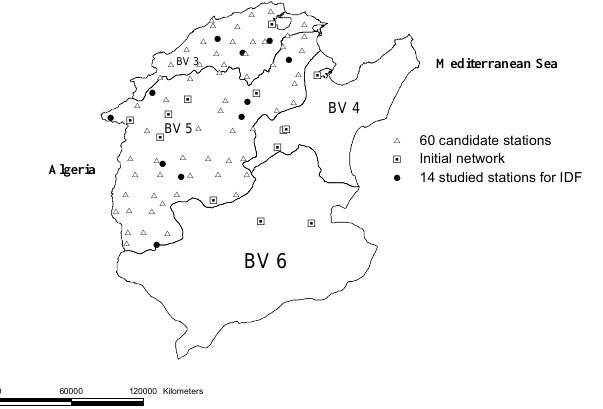
Fig. 1. Location of rain gauges in the study area (Medjerda basin Figure 1. Location of rain gauges in the study area (Medjerda basin BV5 ; Northern BV 5; northern coast basin BV 3; and surrounding basins (Meliane coast basins BV3 and surrounding basins Meliane Basin BV4 ; Central Tunisia basins basin BV 4 and central Tunisia basin BV 6)). BV6 )